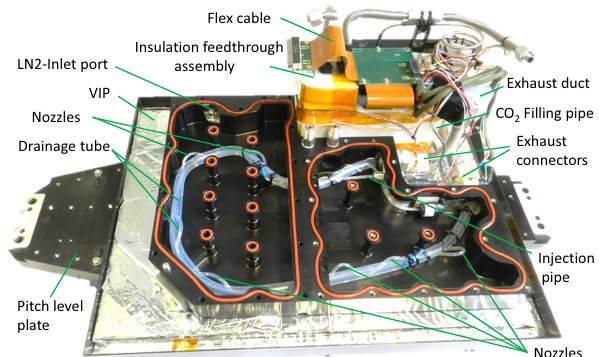
Figure 7. Coolant tank internal view with insulation feedthrough assembly (top right) mounted on the pitch level plate. The injec- tion pipe is used to spray liquid CO 2 into the coolant tank through small nozzles. The liquid CO 2 is introduced over the feedthrough assembly into the tank. Precooling with LN 2 is possible over the dedicated LN 2 inlet. The exhaust gas is guided out by the drainage tube and heat sinking parts of the